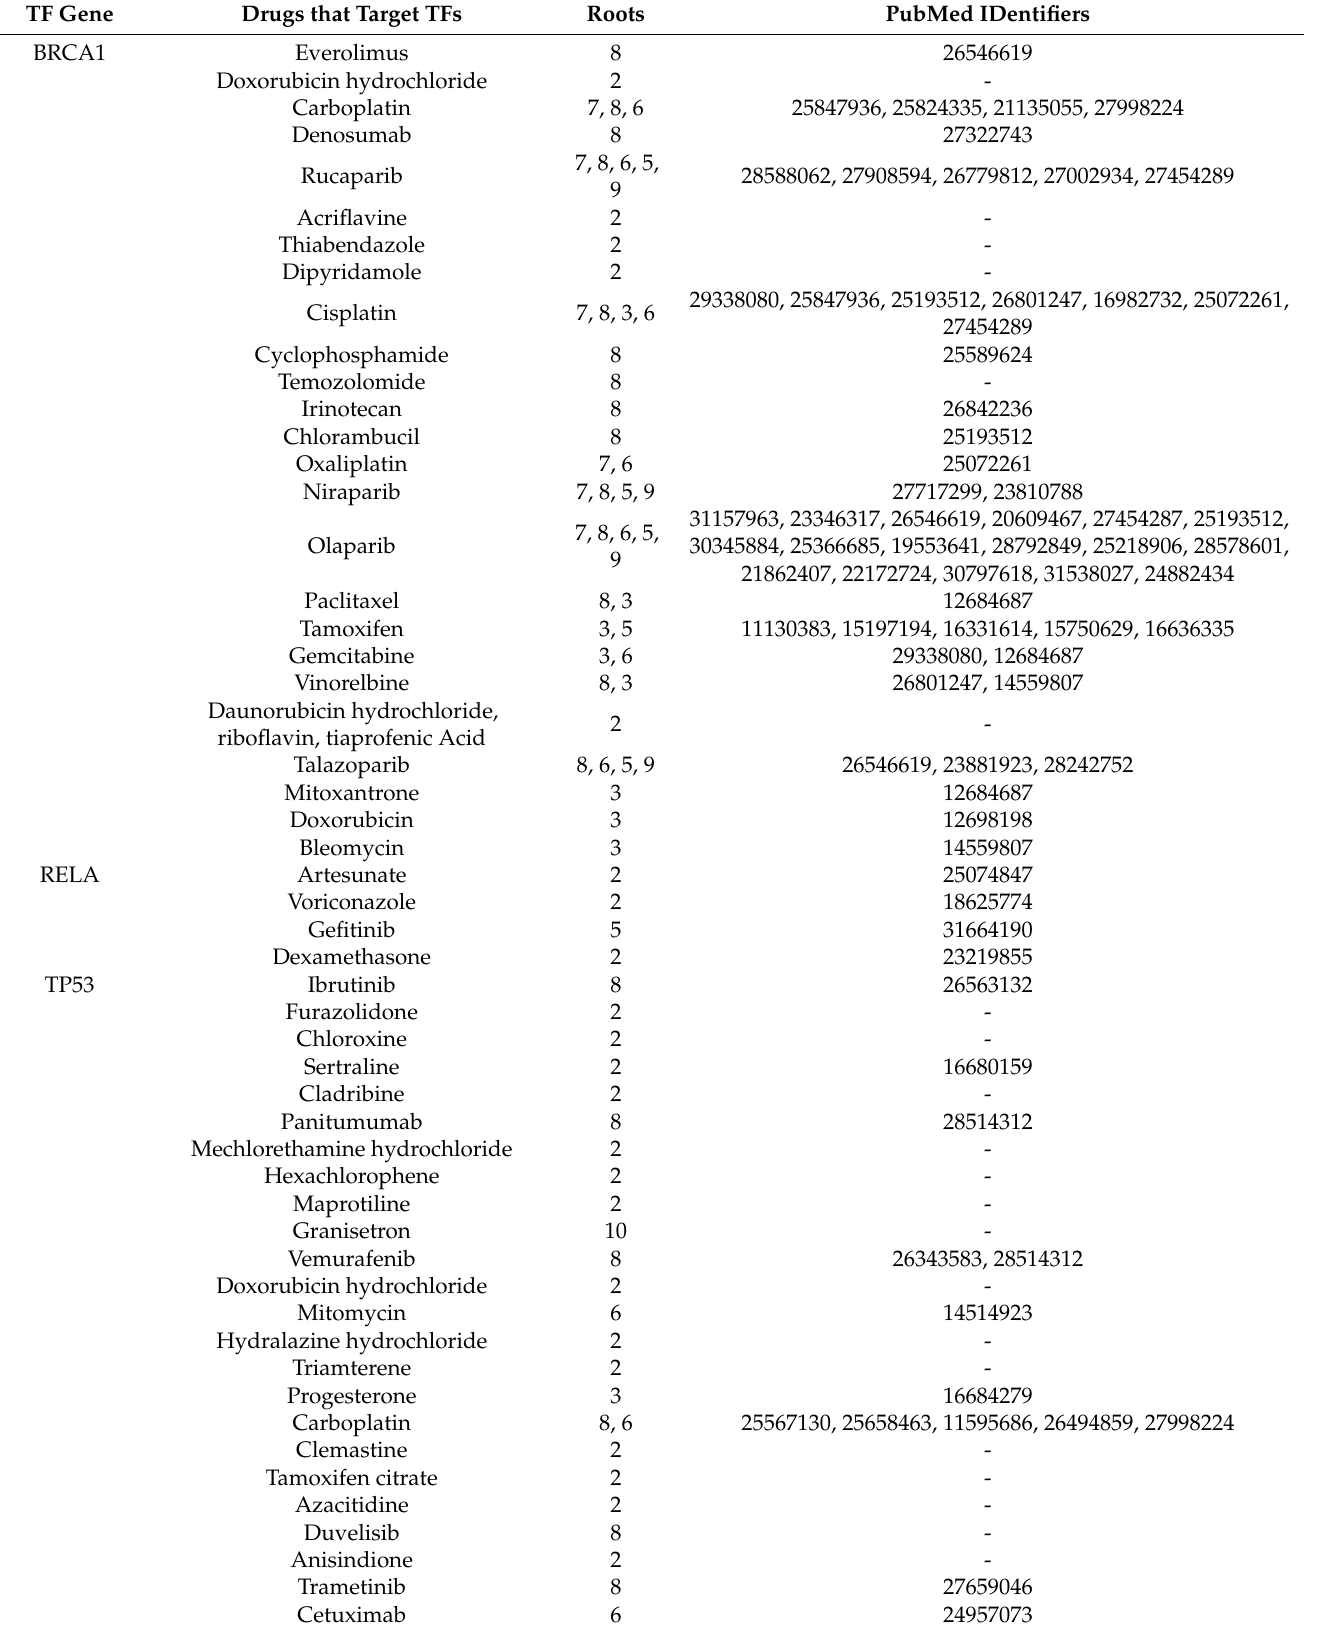
Table 8. Drugs that target